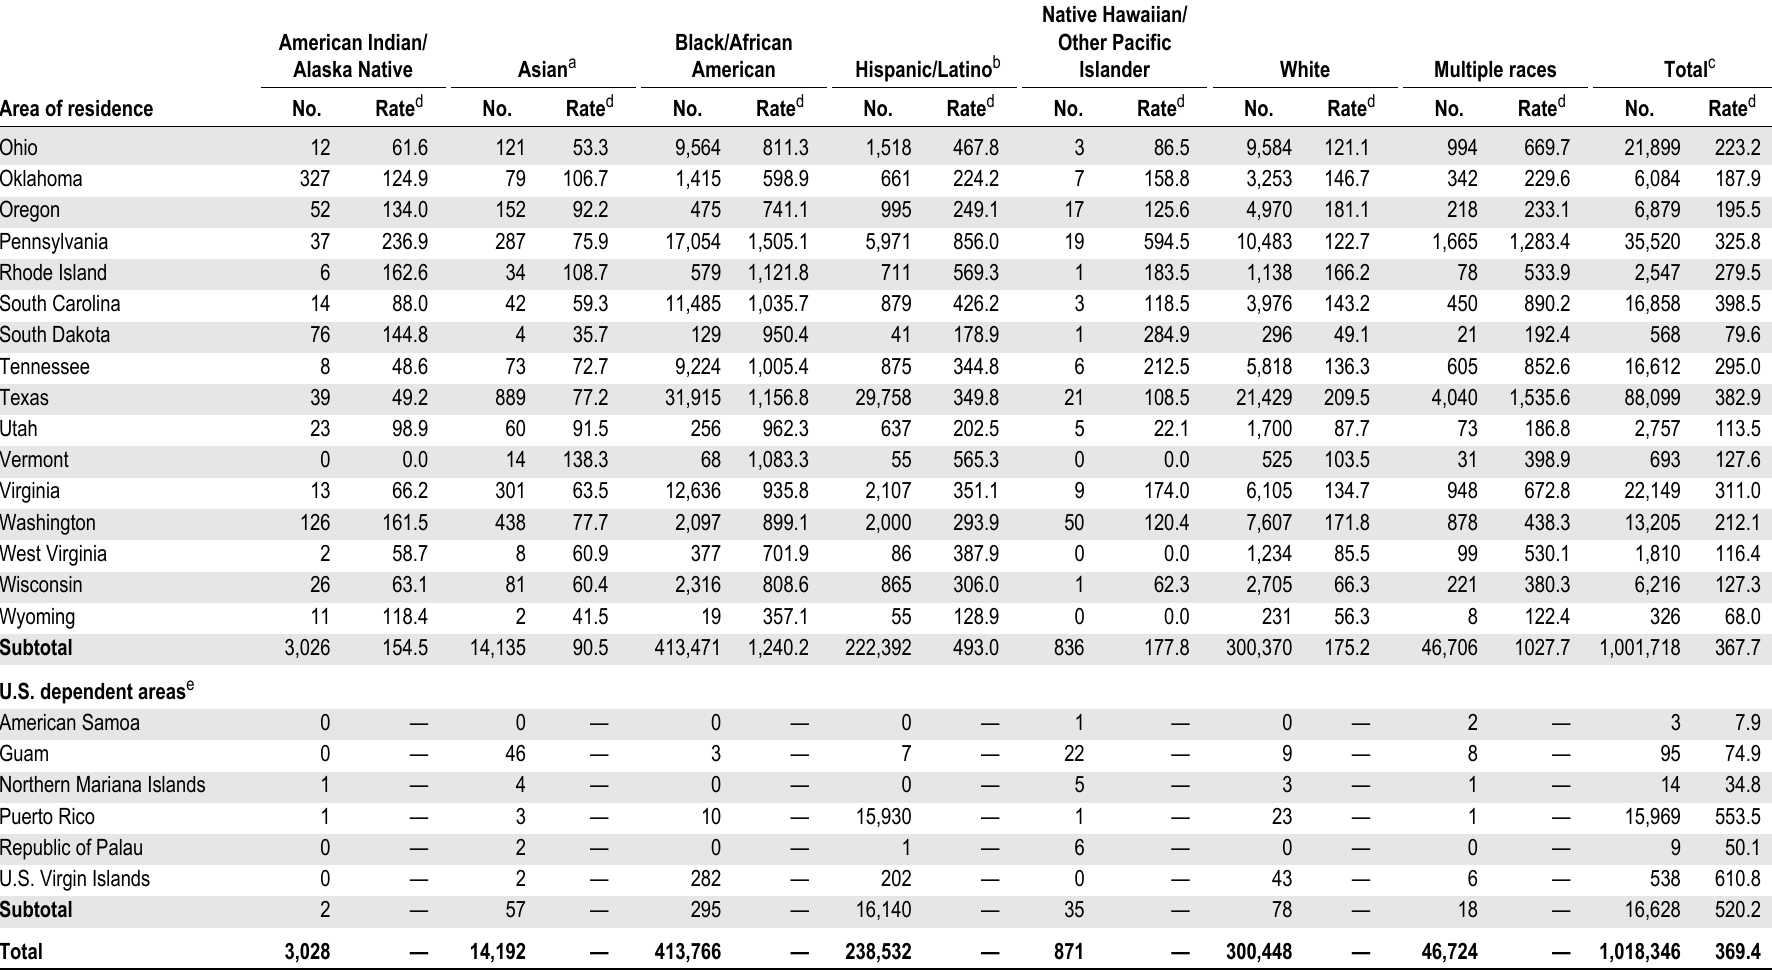
Table 28. Adults and adolescents living with diagnosed HIV infection, by race/ethnicity and area of residence, year-end 2017—United States and 6 dependent areas